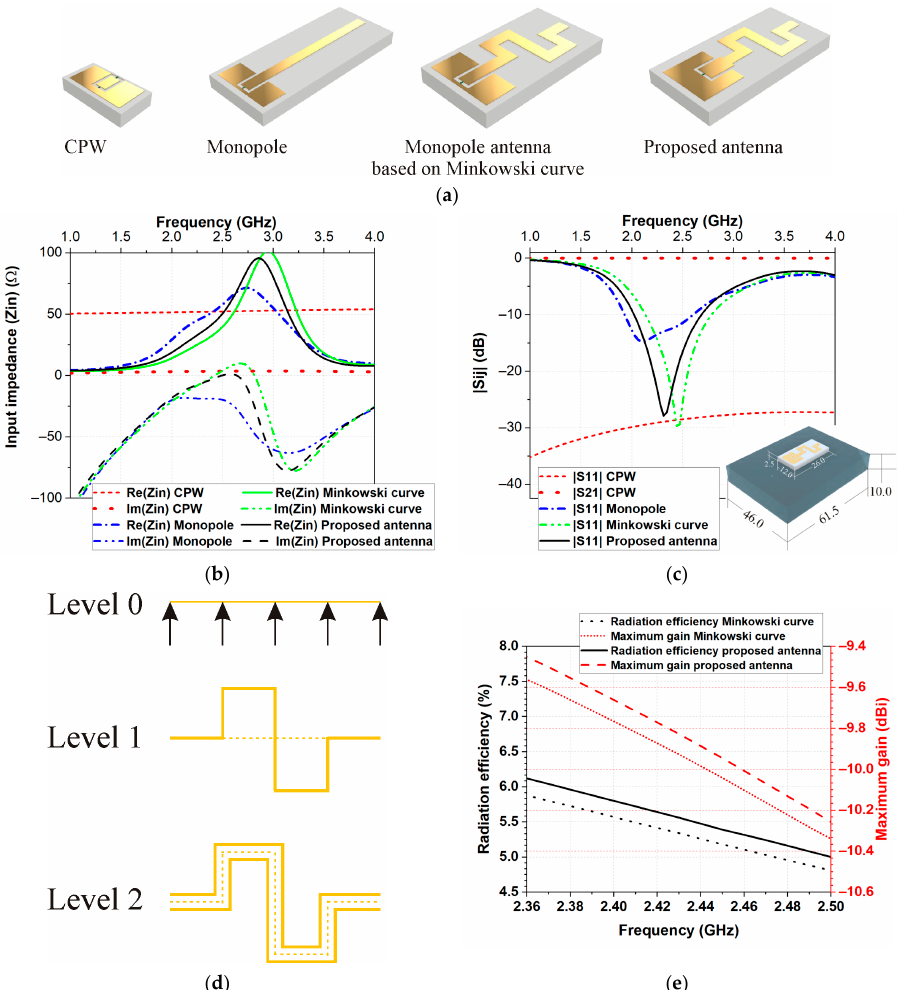
Figure 1. Design process: ( a ) numerical models of CPW and different configurations of the antenna during the design process, ( b ) input impedance, ( c ) magnitudes of the reflection |S 11 | and transmis- sion |S 21 | coefficient, ( d ) generation of the antenna using the quadratic Koch curve, also known as the eight-segment Koch curve or Minkowski curve, and ( e ) comparison of the radiation efficiency and maximum gain of the proposed antenna and monopole antenna based on Minkovski curve when the antennas were placed on Phantom 1.